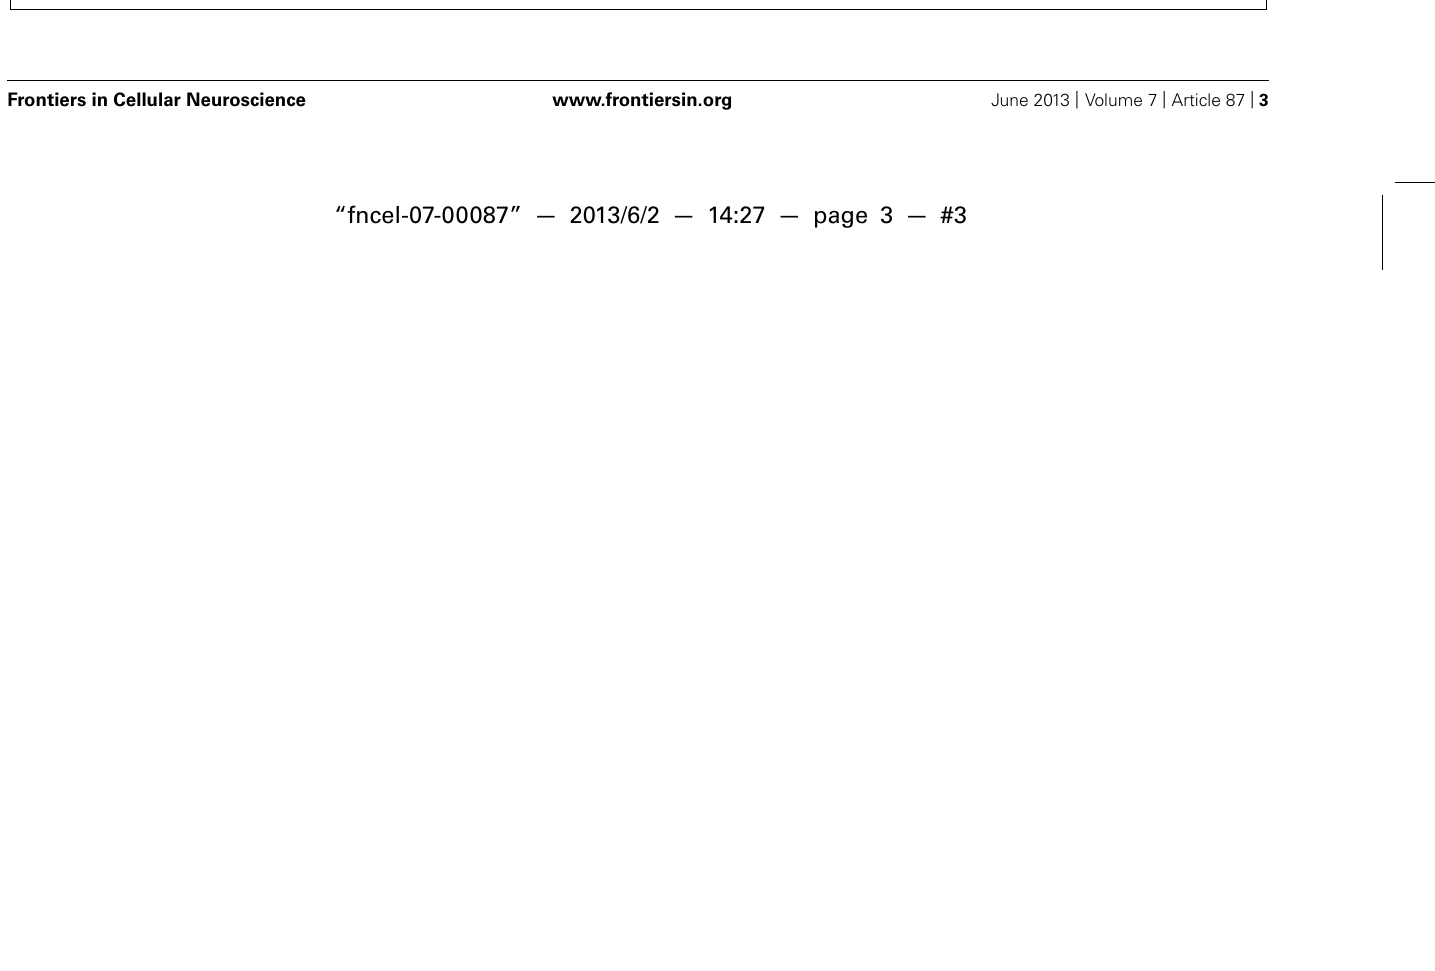
FIGURE 2 | Non-canonical BMP signaling. In addition to Smads, activated BMP receptors activate several intracellular pathways which modulate BMP-dependent cellular responses. Pathways includeTAK-p38, PI3-kinase, Cdc42 or activation of LIMK by binding to the BMPR-II cytoplasmic